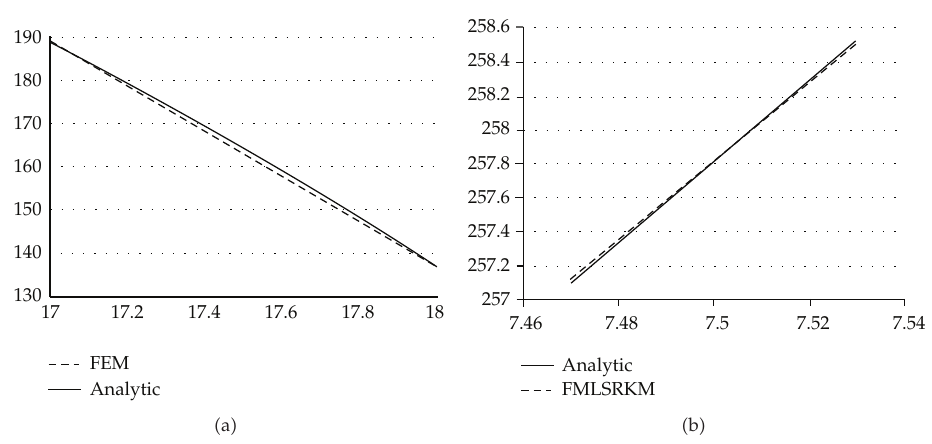
Figure 7: Examples of FEM and FMLSRKM. (cid:2) a (cid:3) Linear approximation of FEM shows maximum di ff erence at the middle of the interval, and (cid:2) b (cid:3) Quadratic approximation of FMLSRKM crosses the exact solution.